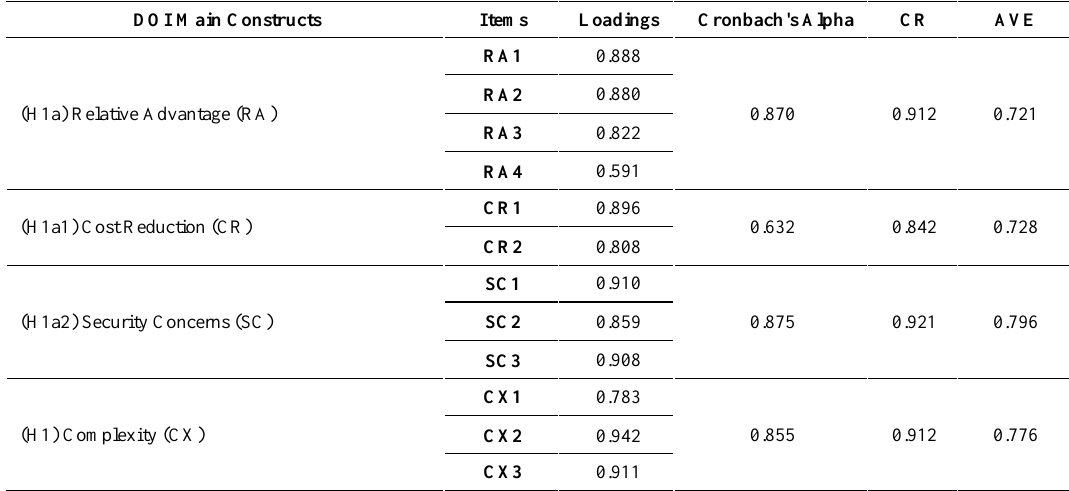
Table 2. DOI and TOE constructs, items, loadings, Cronbach’s Alpha, CR, and AVE